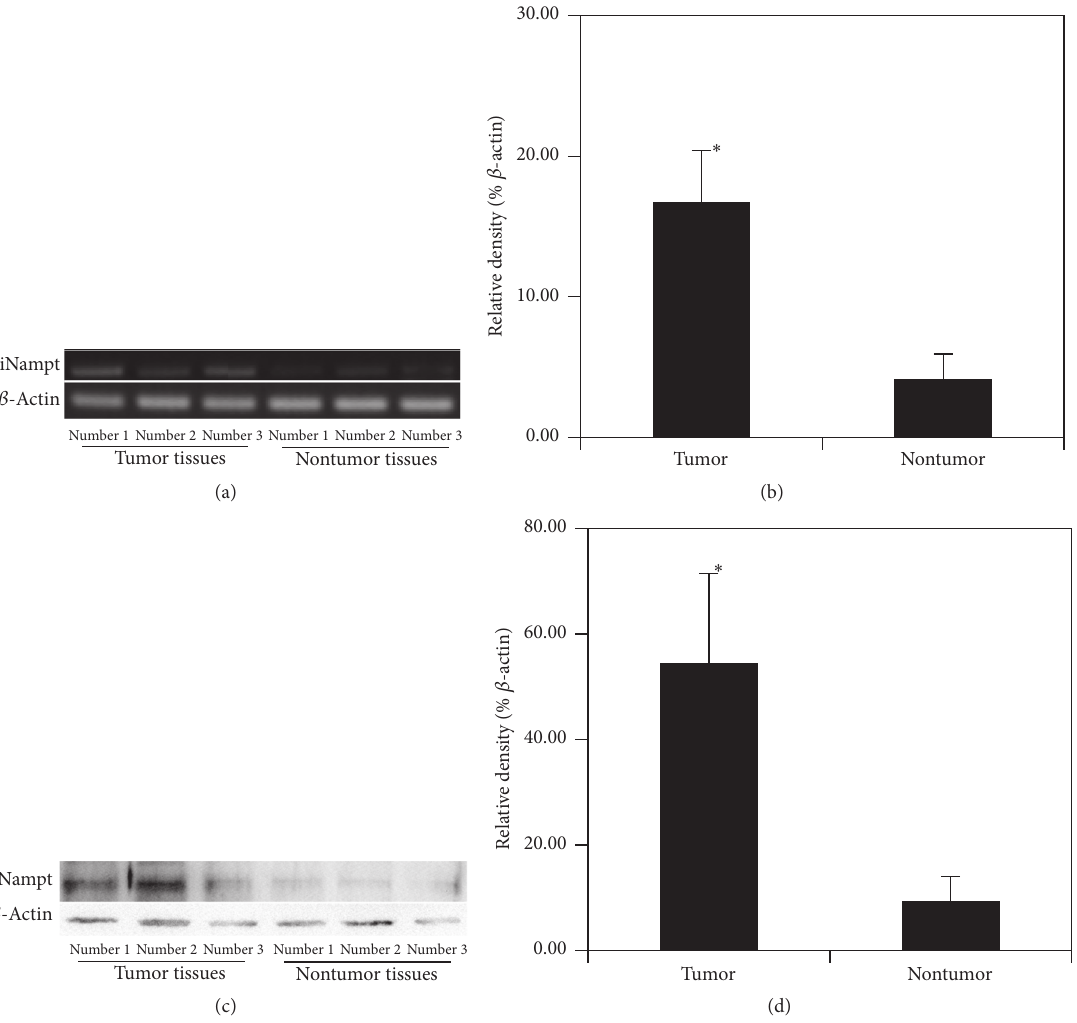
Figure 1: iNampt expression in EGAs tissues and their adjacent nontumor tissues ( 𝑛 = 5; 3 of 5 representative images were shown). Compared to these adjacent nontumor specimens, EGA had upregulated iNampt expression in the mRNA level ((a) and (b), 16.66 ± 3.74% versus 4.14 ±